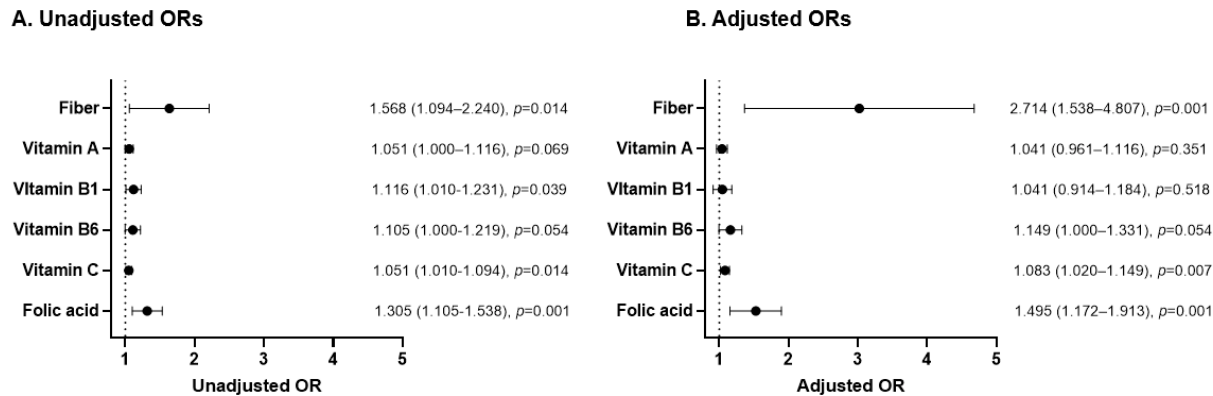
Figure 2. Association between new airflow limitation onset and nutrient intake differences between the baseline and 5-year follow-up. Adjusted for gender, age, smoking history, and FEV 1 /FVC at baseline (2012). ( A ) Unadjusted OR ( B ) Adjusted ORs is added to the end of Figure 2 title. All values are expressed with a 95% confidence interval. Only diet composition with statistical significance in univariate analysis was selected. OR, odds ratio.